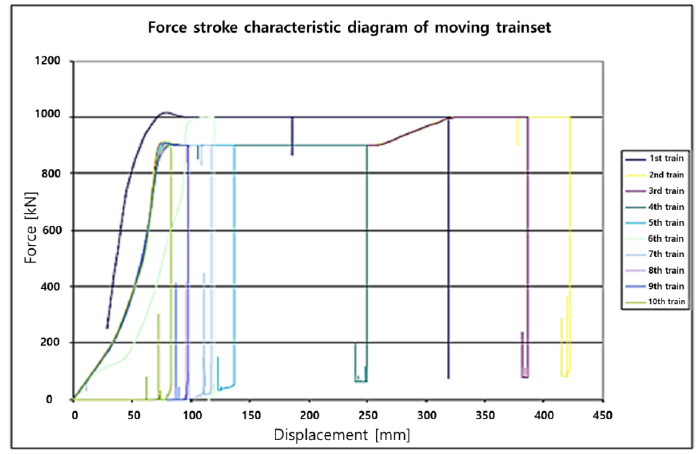
Table 2. Comparison of energy balance during collision.